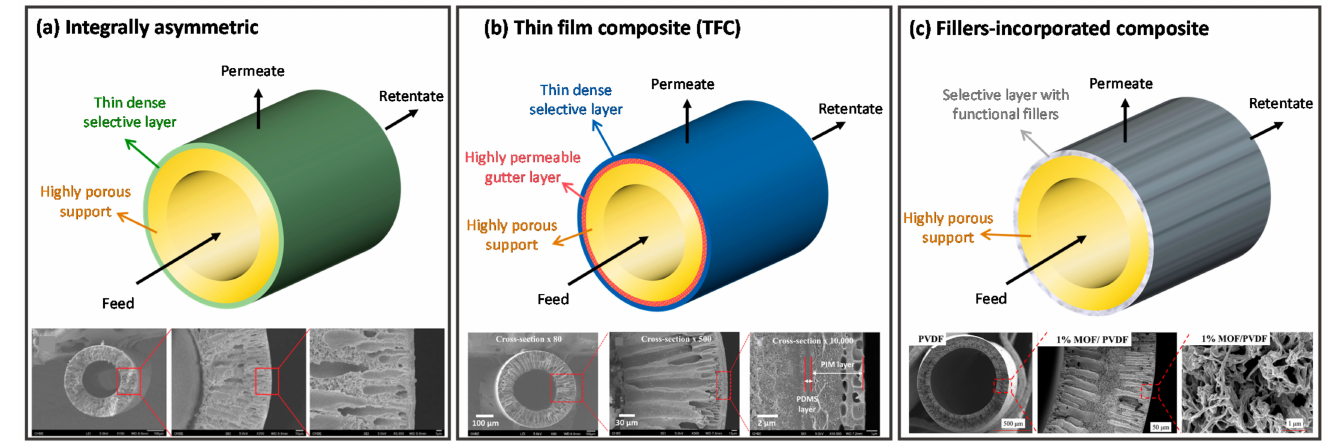
Figure 4. Schematic and cross section morphologies of ( a ) integrally asymmetric, ( b ) TFC, and ( c ) fillers-incorporated composite hollow fibers. Reprinted/adapted with permission from Refs. [66,70,71]. Copyright 2018 and 2021, Royal Society of Chemistry, Elsevier and